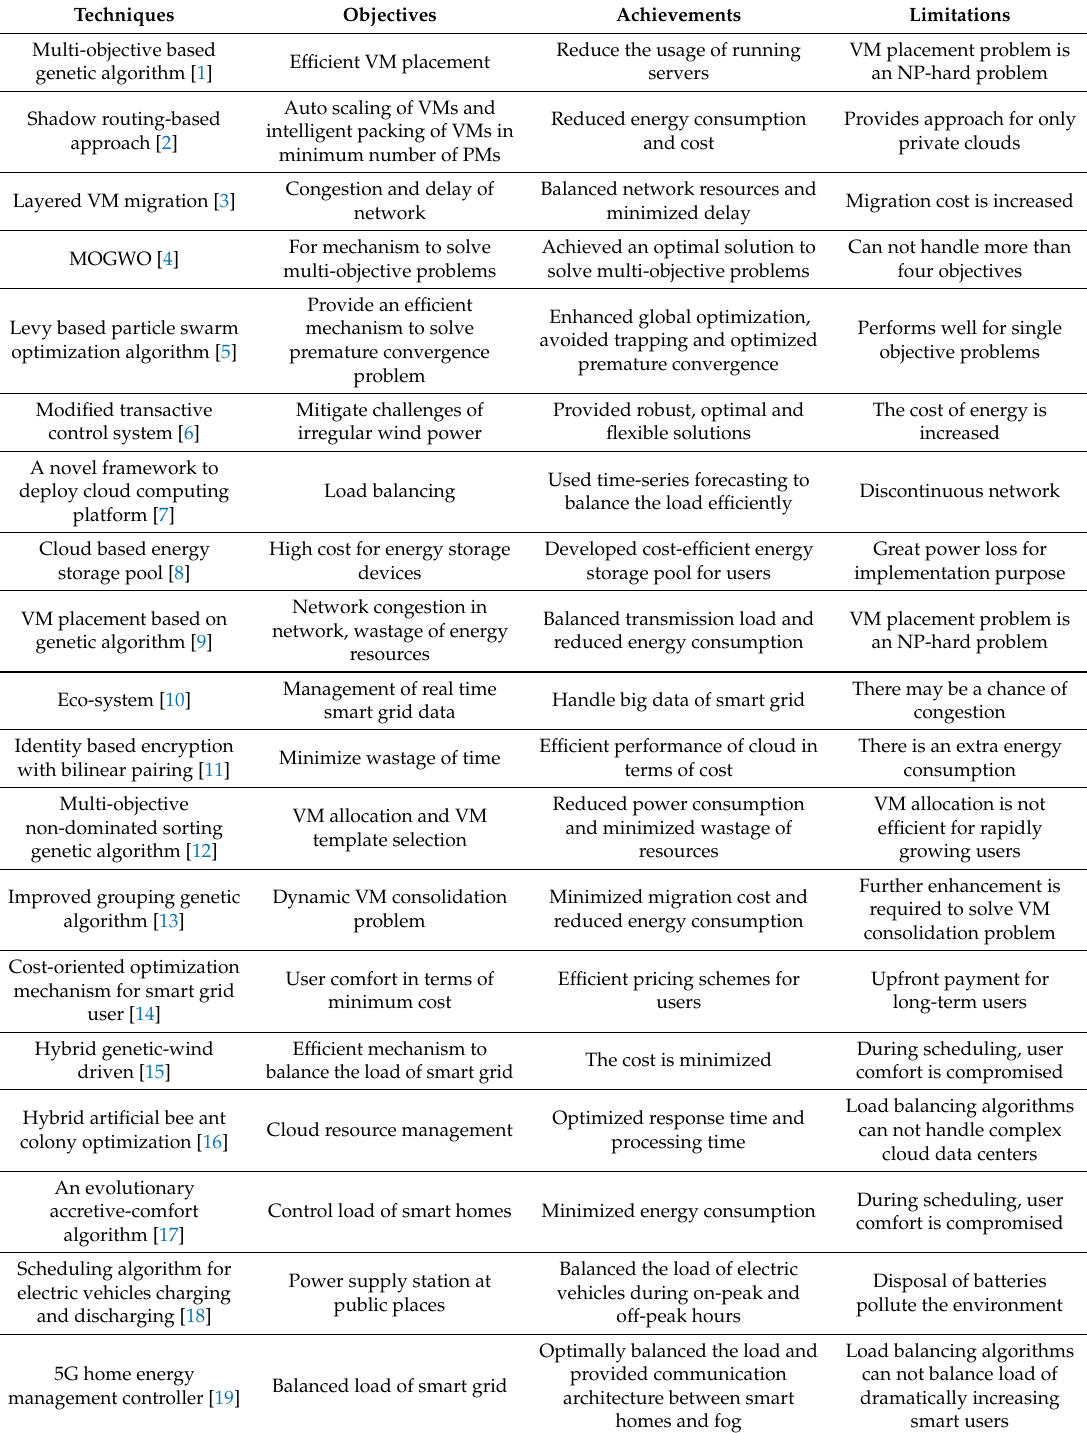
Table 1. Related